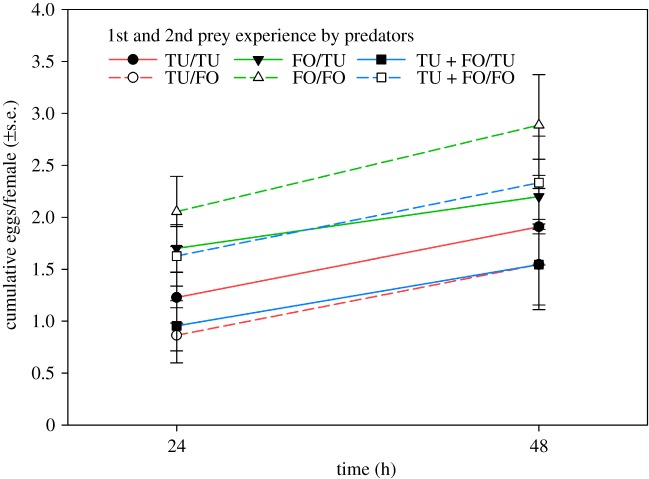
Cumulative mean number of eggs produced within 24 and 48 h by adult A. swirskii females offered six nymphs of T. urticae (TU) and six 1st larvae of F. occidentalis (FO) in the behavioural assay (experiment 1). During the preceding prey experience phase, the juvenile females received in their larval and early protonymphal stage either TU or FO or both, TU + FO, as 1st prey, and from the late protonymphal stage until adulthood either TU or FO as 2nd prey (table 1). Predators that had experienced FO as 1st prey in life (green lines) produced more eggs than predators that had experienced TU or TU + FO as 1st prey in life (red and blue lines) (LSD following GLM; p < 0.05).